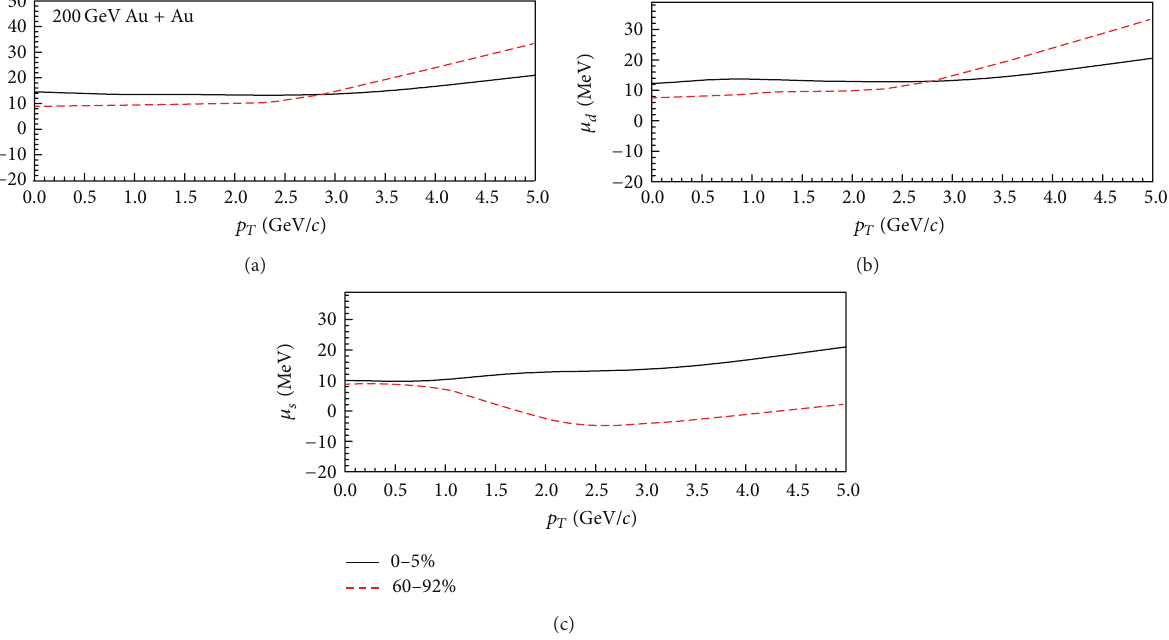
Figure 6: The same as Figure 5, but showing the results in Au-Au collisions at √𝑠 𝑁𝑁 = 200